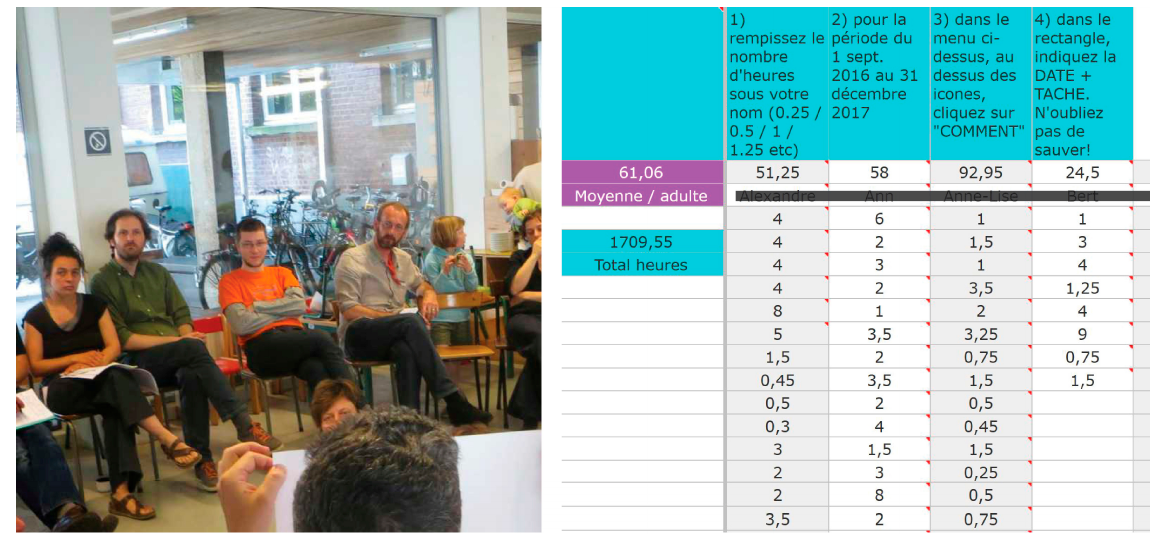
Figure 6. Project elaboration meeting and timesheet (http://www.echappee.collectifs.net, accessed on 11 June 2019, source: Matthieu Liétart, 2013).